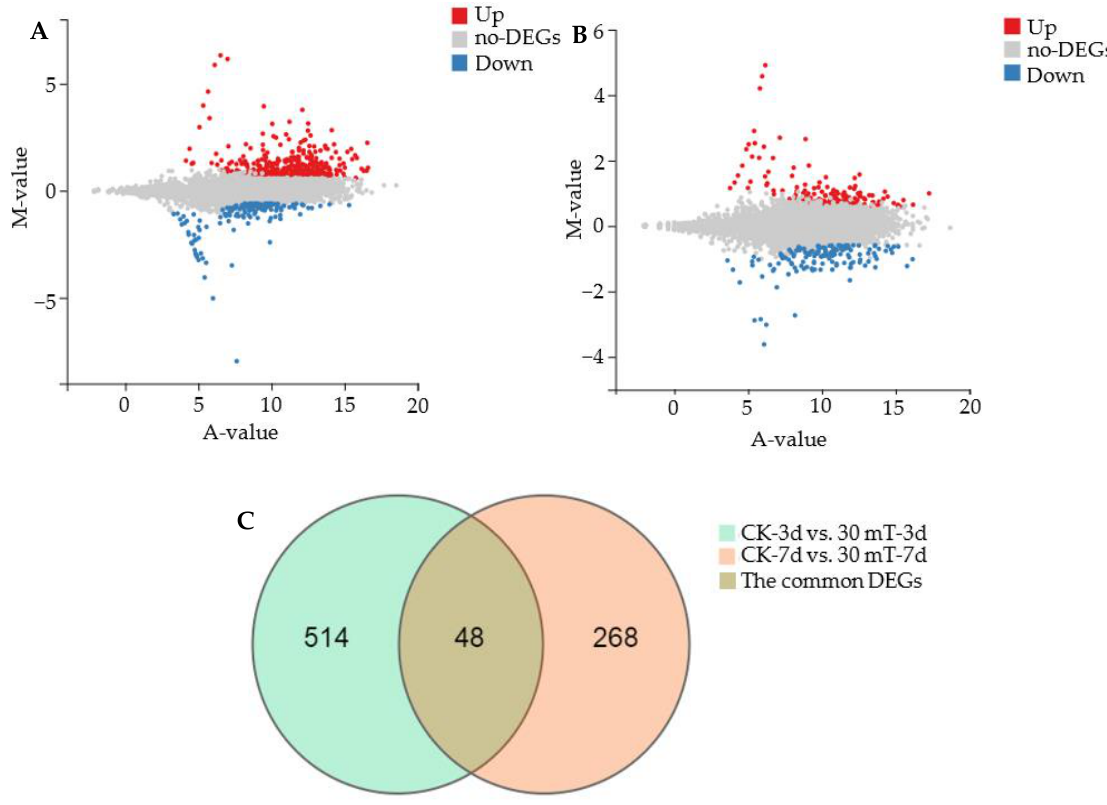
Figure 4. Differentially expressed genes (DEGs) in M. ruber M7 under 30 mT SMF. ( A ): MA -plot (M-versus-A plot) analysis of the DEGs in the CK-3d vs. 30 mT-3d group. The A-value on the X -axis represents the gene expression level calculated by log 2 , and the M-value on the Y -axis represents the gene difference multiple calculated by log 2 ; ( B ): MA -plot analysis of DEGs in CK-7d vs. 30 mT-7d group; ( C ): Venn diagram analysis of the DEGs.